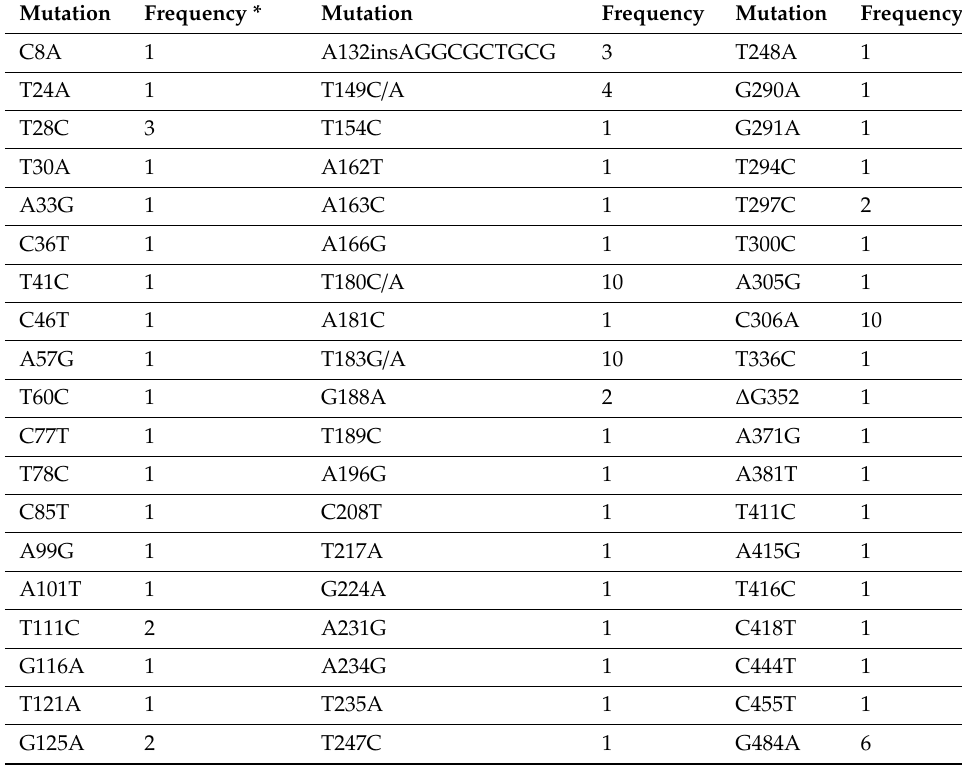
Table 3. Frequency of mutations in the noncoding control region of Karolinska Institute polyomavirus.